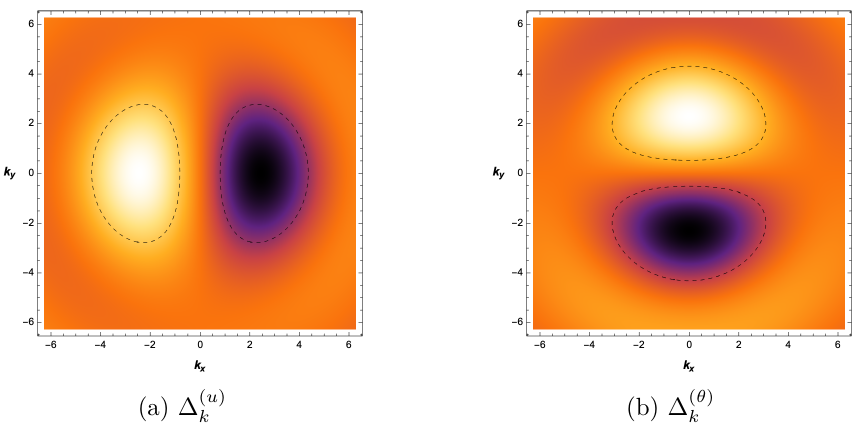
Figure 1. Two components gap function from vector wave model with l p = 1 .